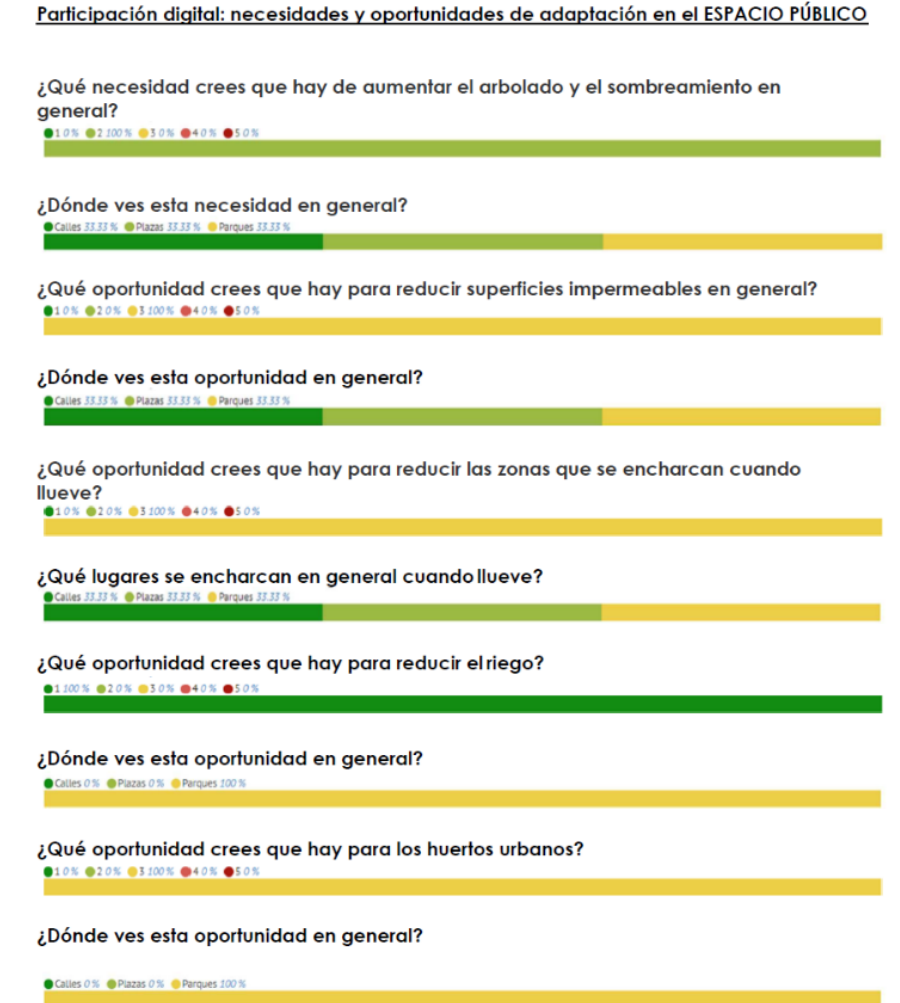
Figure 7. Screenshot of the consultation method of the on ‐ line platform of Legazpi.